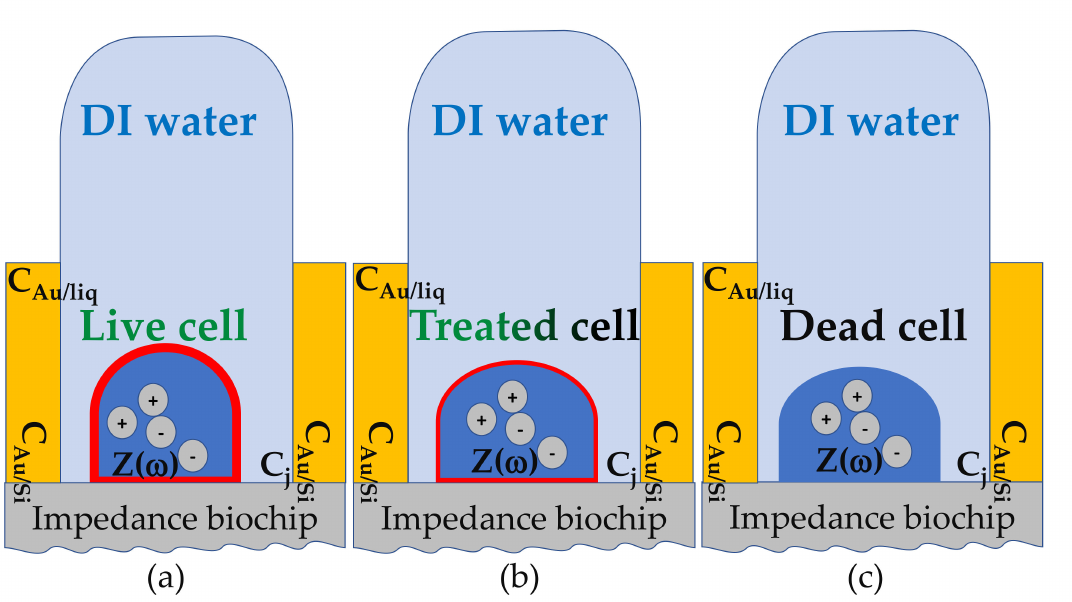
Figure 10. Schematic sketch of a cross-section through the impedance biochip with a ( a ) live, ( b ) treated, and ( c ) dead L. sphaericus JG-A12 cell in DI water attached to the surface of the impedance biochip. The effective impedance Z( ω ) of the cell is added in parallel and in series to the PS5 and BS5 impedance biochip, respectively. The height of the cross-section of the Au ring top electrode (yellow) amounts to 150 nm. The height of 25 µ L liquid (light blue) inside the region of the Au ring top electrode amounts to ca. 1 mm (Figure 3b). The water drop is held on the underside by the approximately 150 nm high Au ring top electrode and prevented from leaking. The place of origin of capacitance of the ring top electrode C Au/Si , of the capacitance between ring top electrode and liquid C Au/liq , of capacitance between liquid and surface of impedance biochip C j and of the effective impedance of the L. sphaericus JG-A12 cell Z( ω ) is also